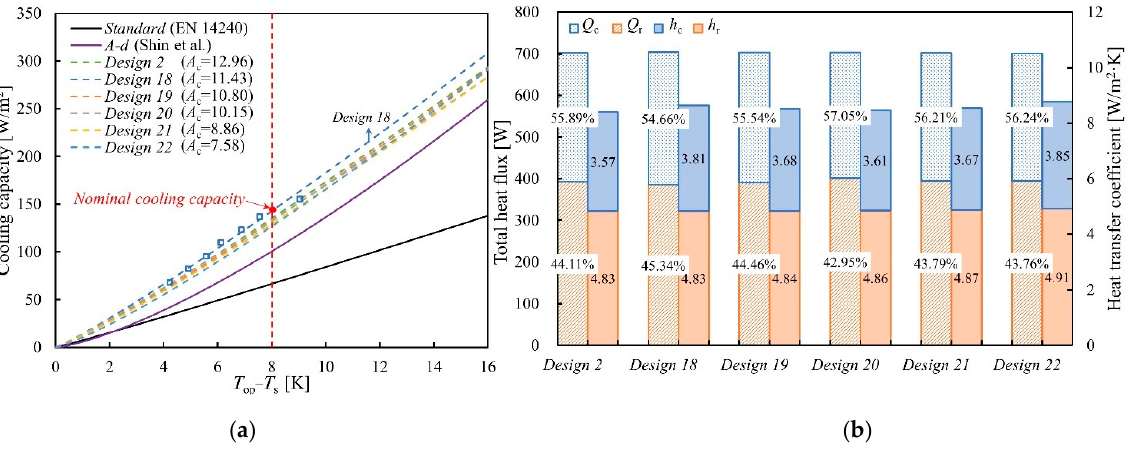
Figure 11. Comparison of different coverage areas ( a ), cooling capacity curves [27,32] ( b ), and thermal performances under a cooling load of 1405.02 W.